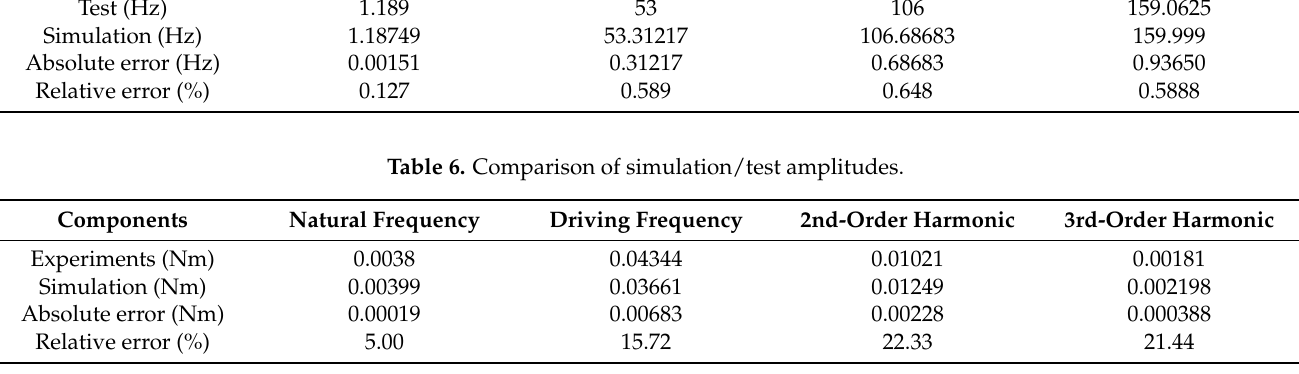
Figure 16. Simulation and test results of the disturbance torque.